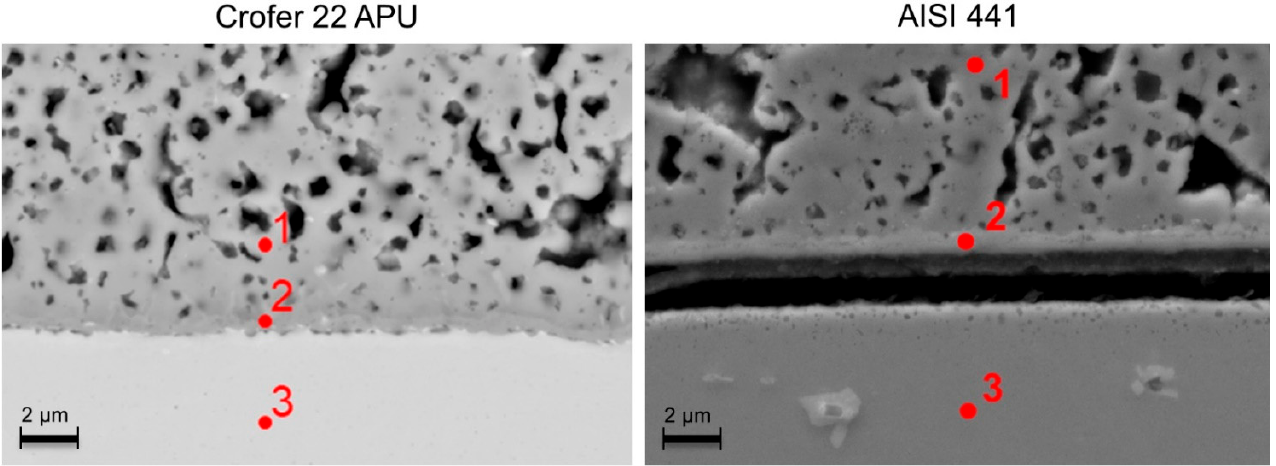
Figure 8. MCO coated Crofer 22 APU ( left ) and AISI 441 ( right ) after 1500 h at 700 °C. EDS point analysis was conducted from three spots indicated by red markers. The compositions in these spots are given in Table 4. Table 4. Element concentrations in wt./at.% measured with EDS analysis of MCO coated Crofer 22 APU and AISI 441 after 1500 h at 700 °C. The location of the analysis spots is marked in Figure 8. The presence of Al likely originates from the polishing process.